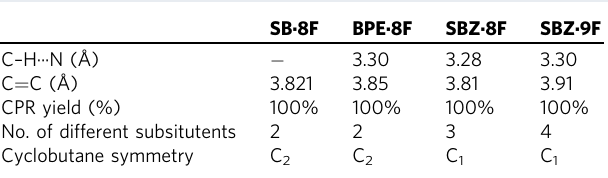
Table 2 Selected parameters of photoreactive cocrystals and cyclobutanes of